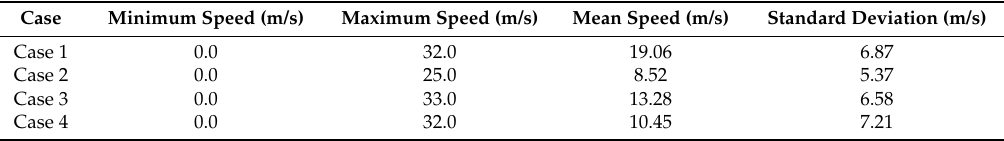
Figure 2. The analyzed wind speed distribution cases. ( a ) Multimodal distribution 1; ( b ) Multimodal distribution 2; ( c ) Unimodal distribution; ( d ) Multimodal distribution 3. Table 1. Statistical properties of the observed data.